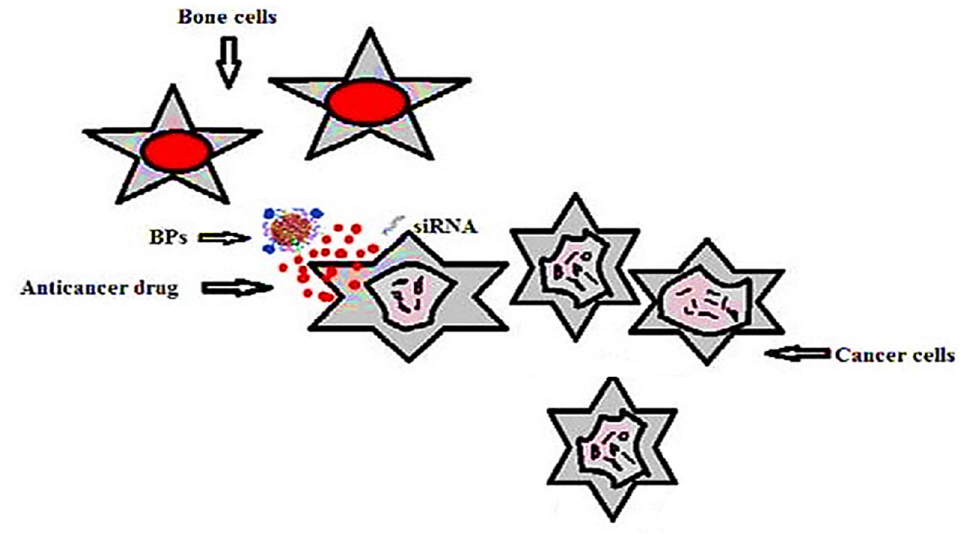
Figure 36. Drug delivery system for bone cancer.